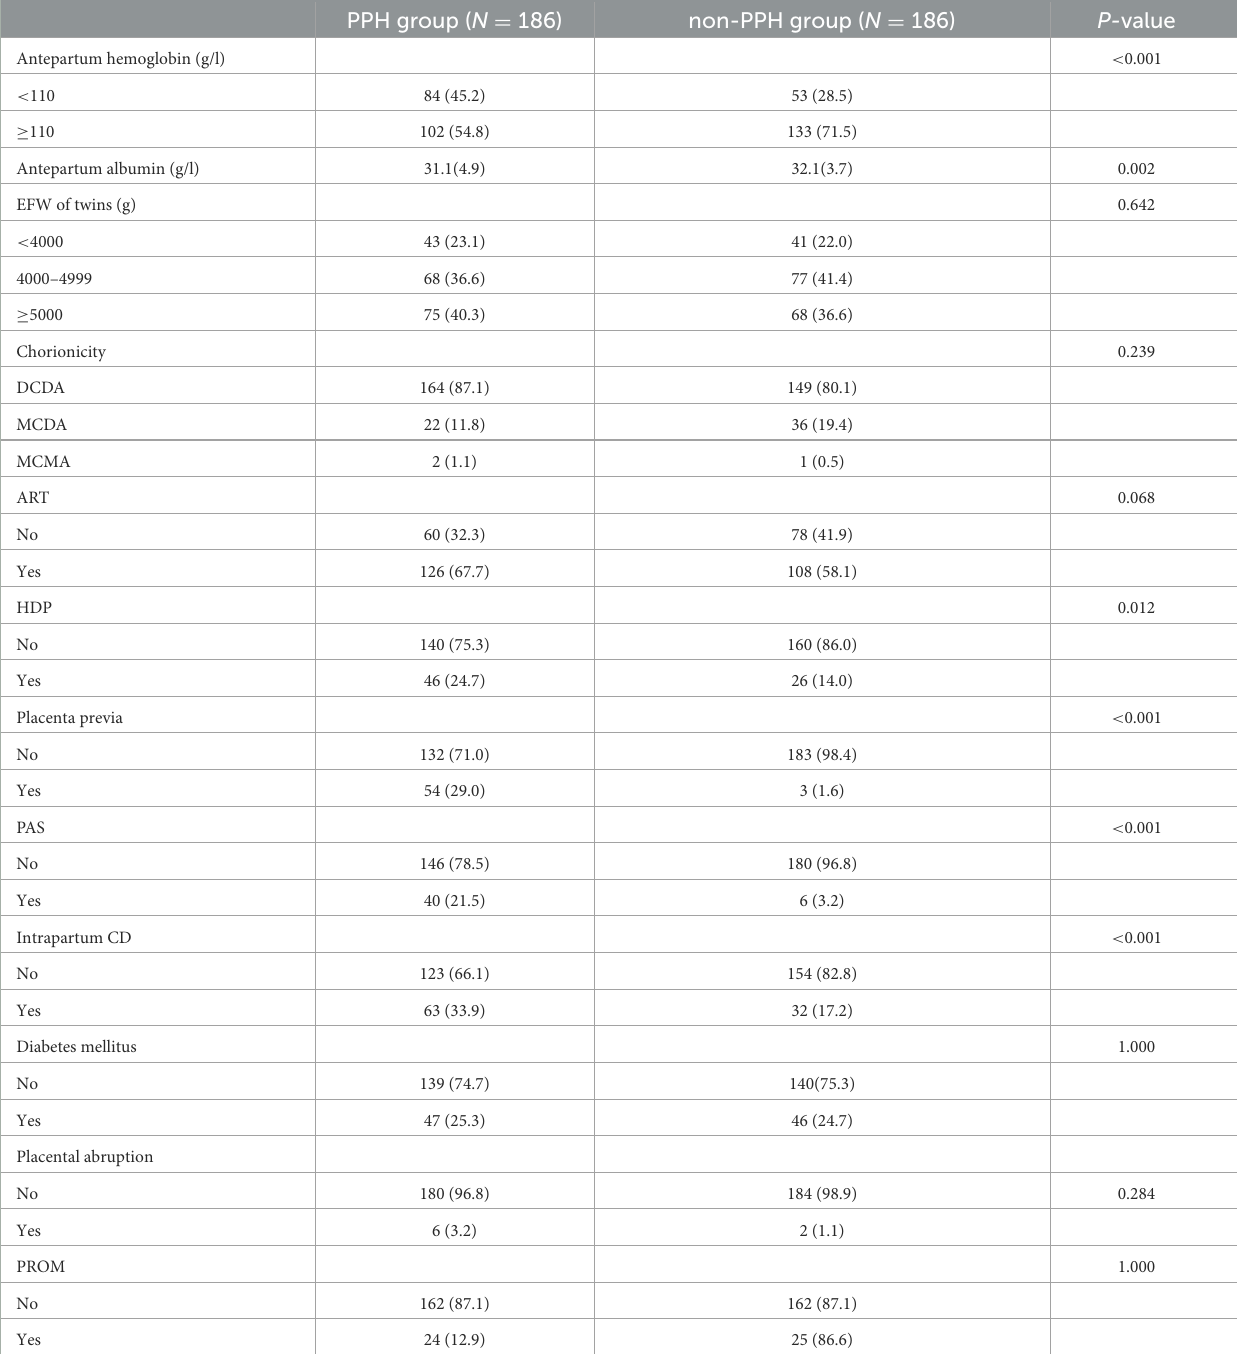
TABLE 2 Univariate logistic regression analysis of the risk factors for PPH after cesarean delivery of twin pregnancies. PPH group ( N = 186) non-PPH group ( N = 186) P- value Antepartum hemoglobin (g/l) <